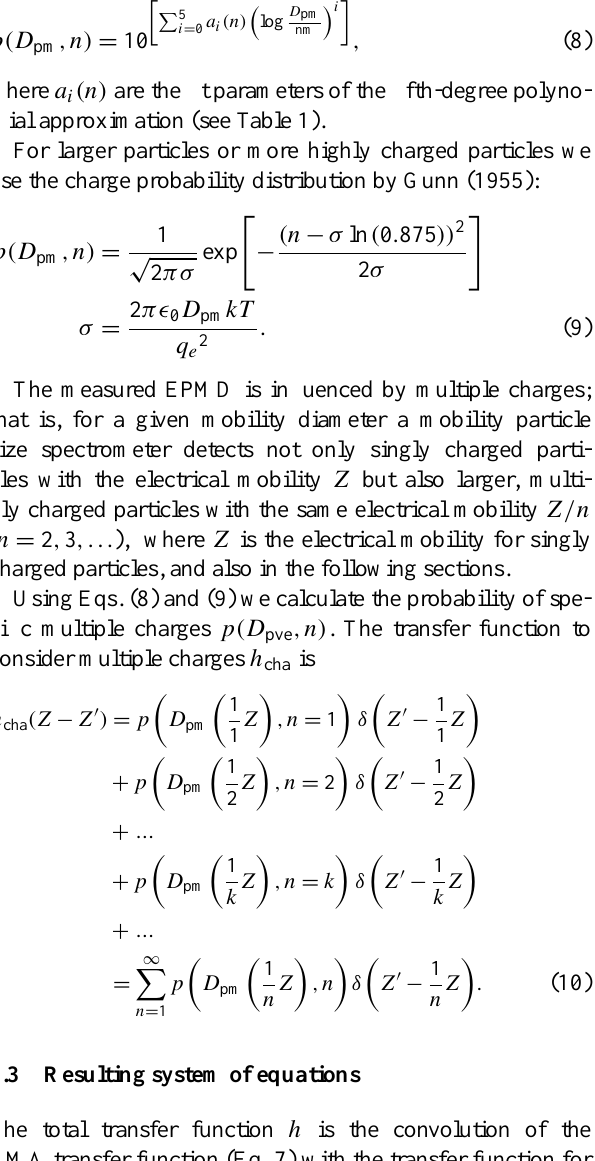
Fig. 3a: raw electrical particle mobility distribution (EPMD) in plain concentration